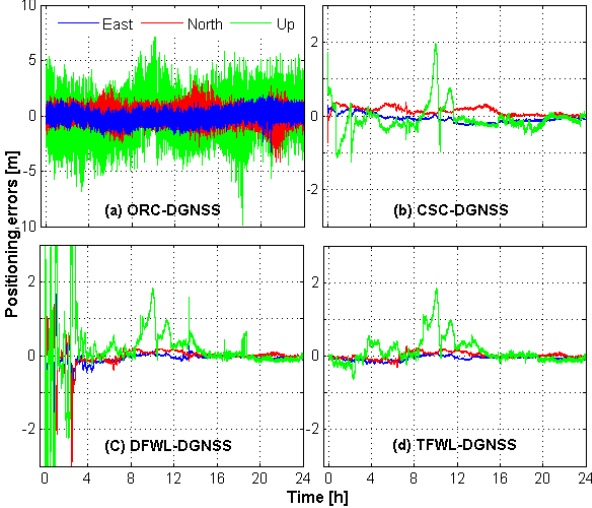
Figure 6. Positioning errors of ORC-DGNSS, CSC-DGNSS, DFWL-DGNSS and TFWL-DGNSS for baseline WHCD-WHHP.